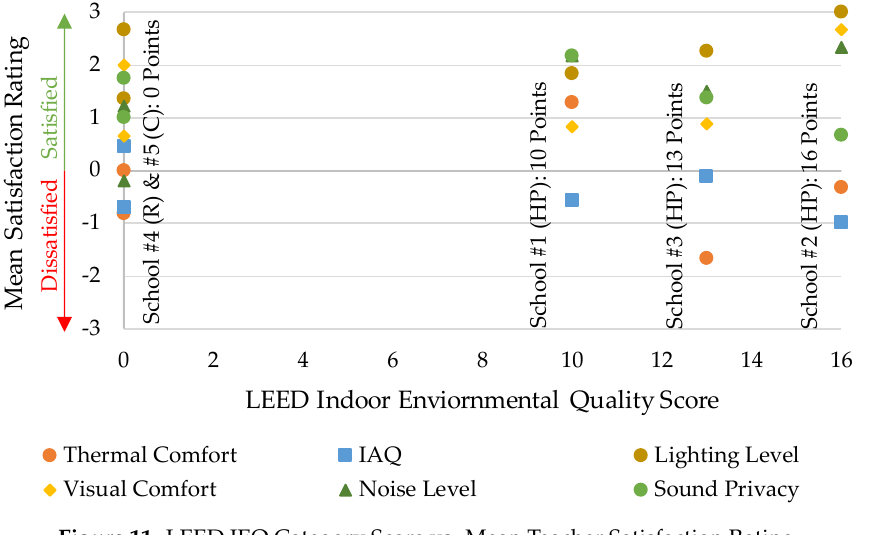
Figure 11. LEED IEQ Category Score vs. Mean Teacher Satisfaction Rating.